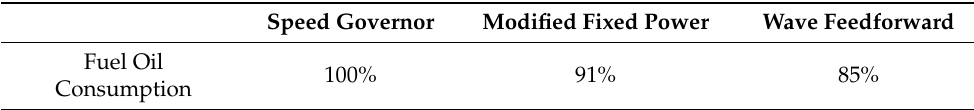
Table 6. Voyage results according to speed control